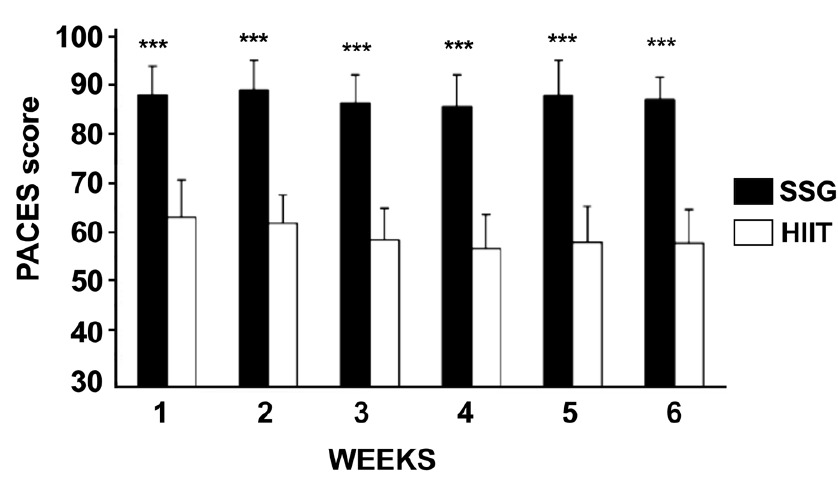
Figure 4. Physical Activity Enjoyment Score (PACES) measured in each week of high intensity interval (HIIT) or small-sided games (SSG) training. *** p < 0.01.